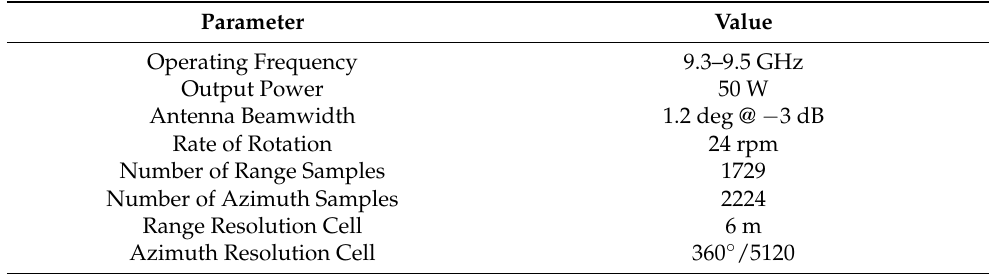
Table 3. X-band experimental radar